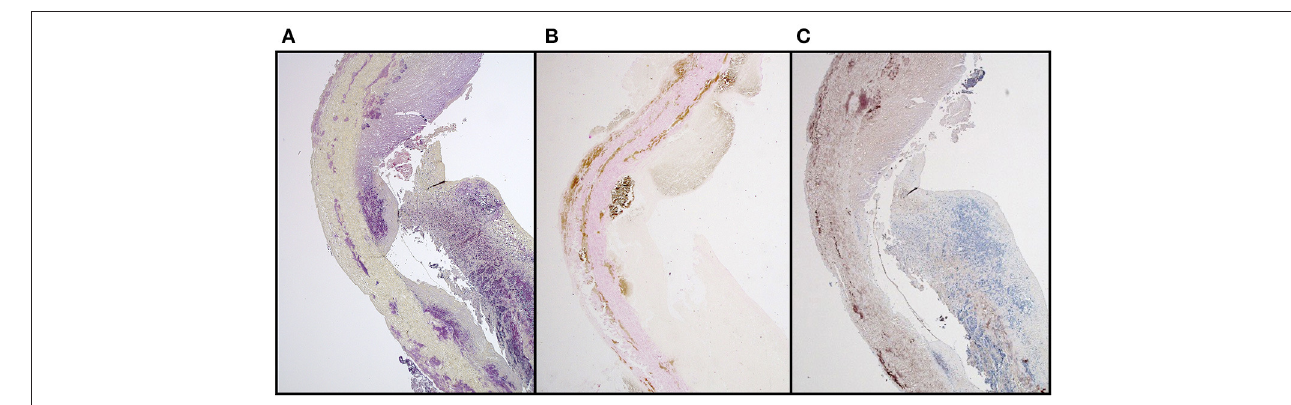
FIGURE 6 | IgG binding in areas of Gram-positive bacterial contamination together with mineralization in a stented, GA-fixed, mitral valve pericardial bioprosthesis retrieved after 112 days (A) Brown & Brenn stain (B) Von Kossa & Van Gieson stain (C) Anti-Sheep IgG.